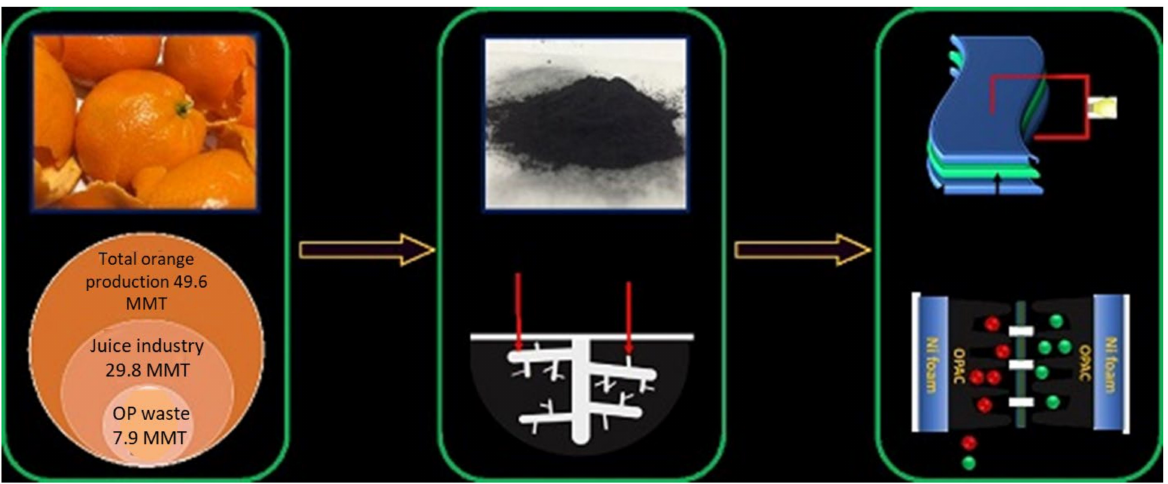
Figure 12. Orange peel by using pyrolysis and pre-carbonization process. Adapted with permission from Ref. [116].